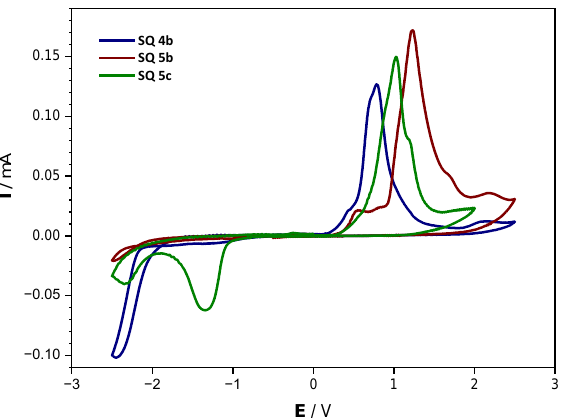
Figure 10. Voltammograms of the drop-cast thin films of pristine squaraine compounds measured using cyclic voltammetry.